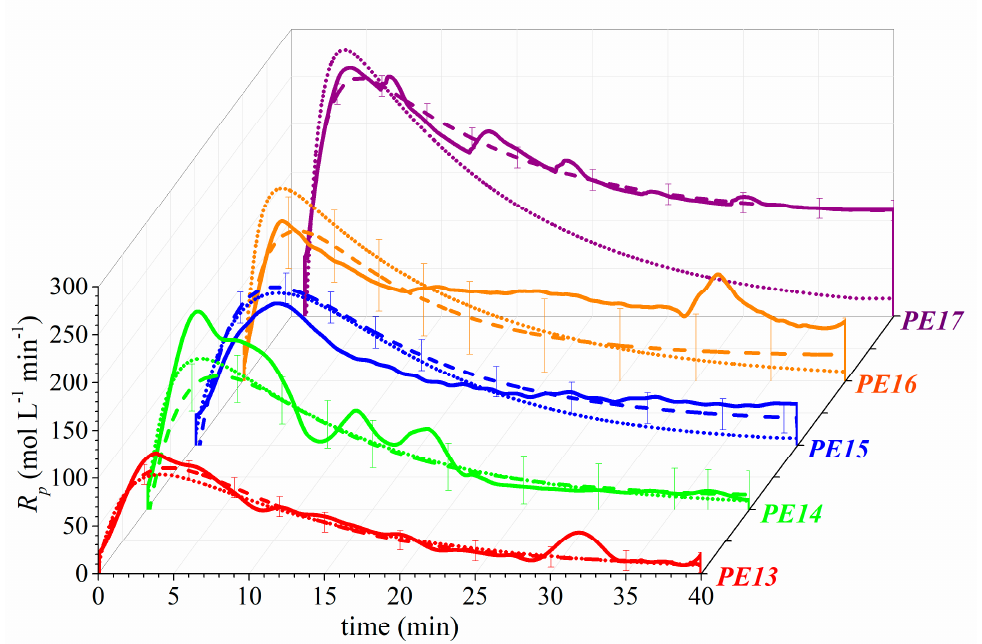
Figure 5. Polymerization rate profiles using Zr1/B3 as a catalytic system, varying the temperature and the [B] 0 for experimental data (continues lines): Model 1 (dashed lines), and Model 2 (dotted lines). The operating conditions are shown in Table 6. Bars denote the standard deviations ( S ) for Model 1.